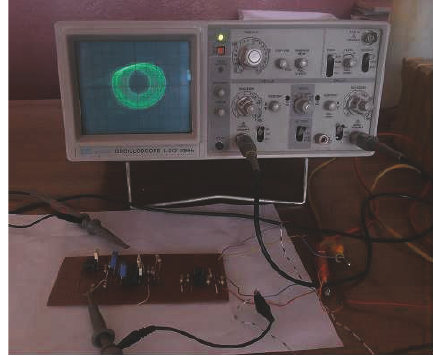
Figure 9: Implemented circuit was measured by using an